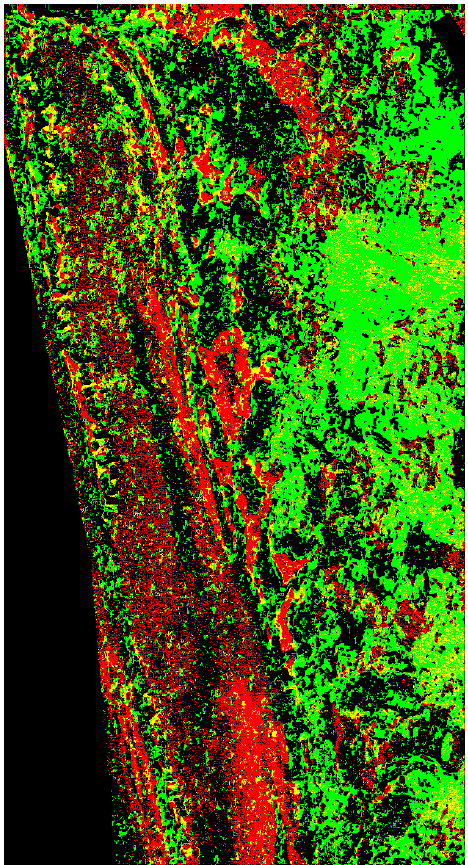
Figure 7. Using the stereo method, green pixels are where predicted depth is within 1 m of true depth. Using the SAMBUCA method, red pixels are where predicted depths are within 1 m of true depth. When both are within 1 m, the pixels are yellow.